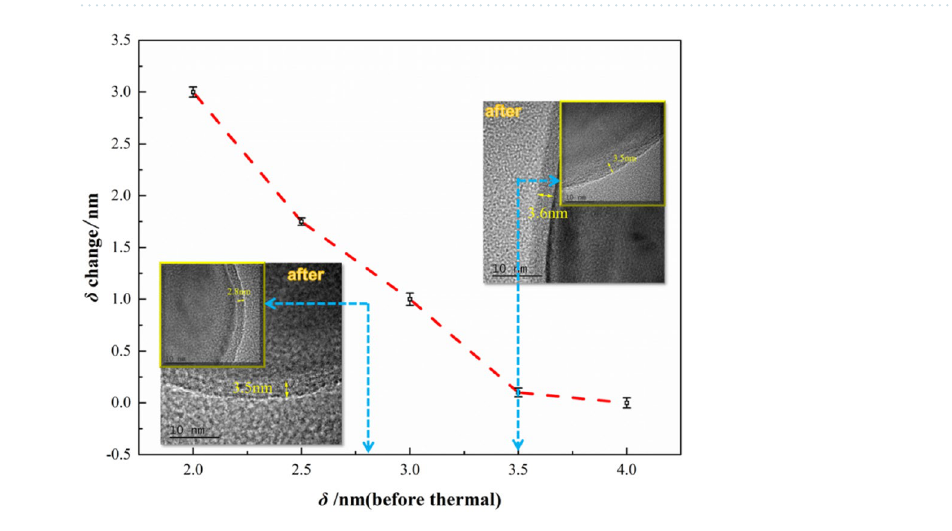
Figure 5. Changes in coating thickness before and after